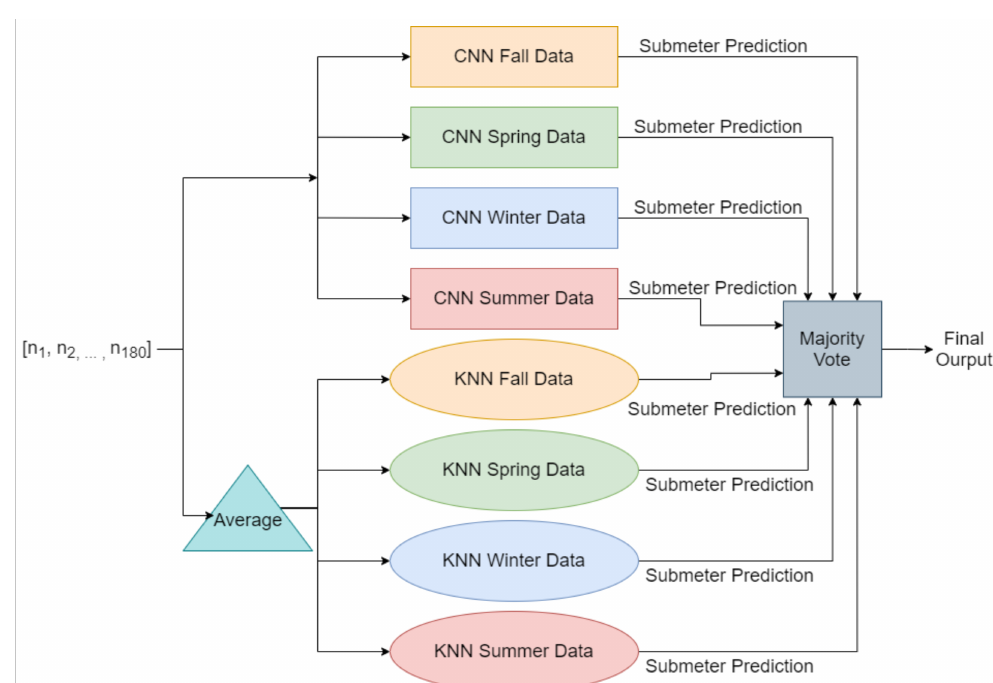
Figure 3. Ensemble methodology: the array input represents the watt-hour data from the UCI database; n 1 is the first data point of the 3-h interval; n 180 is the last data point of the 3-h